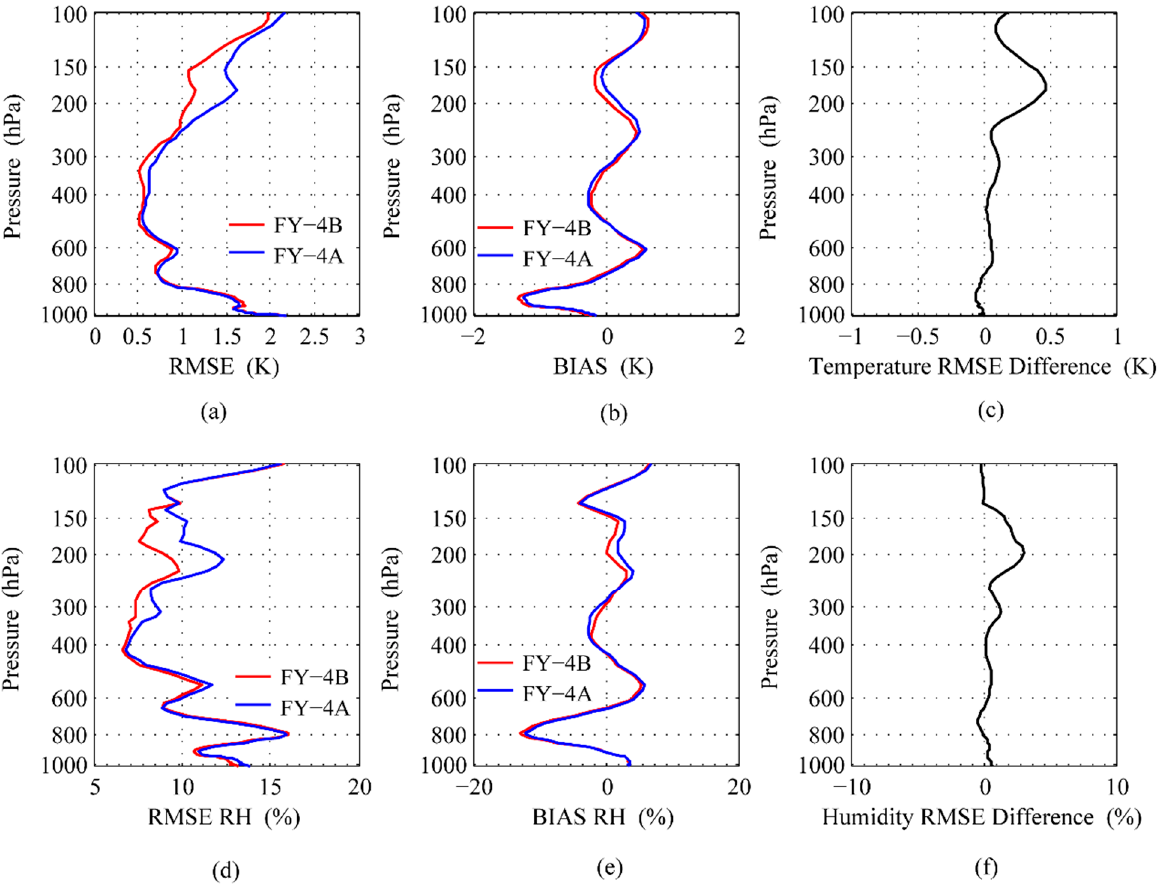
Figure 7. The retrieval results of FY-4A and FY-4B. Red lines plot FY-4B. Blue lines plot FY-4A: ( a ) Temperature RMSE; ( b ) Temperature BIAS; ( c ) Temperature RMSE difference between FY-4A and FY-4B; ( d ) Humidity RMSE; ( e ) Humidity BIAS; ( f ) Humidity RMSE difference between FY-4A and FY-4B. Table 4. The retrieval accuracy of FY-4A and FY-4B corresponding to the